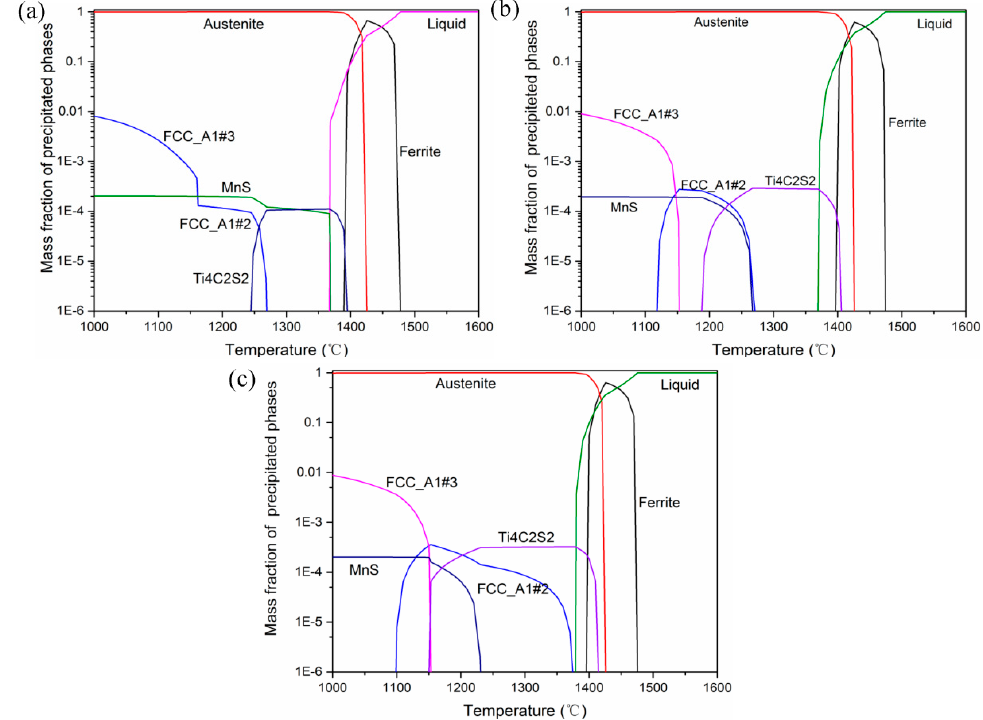
Figure 13. Equilibrium solidifications of H13 ingots. ( a ) Ti-1 sample; ( b ) Ti-2 sample; ( c ) Ti-3